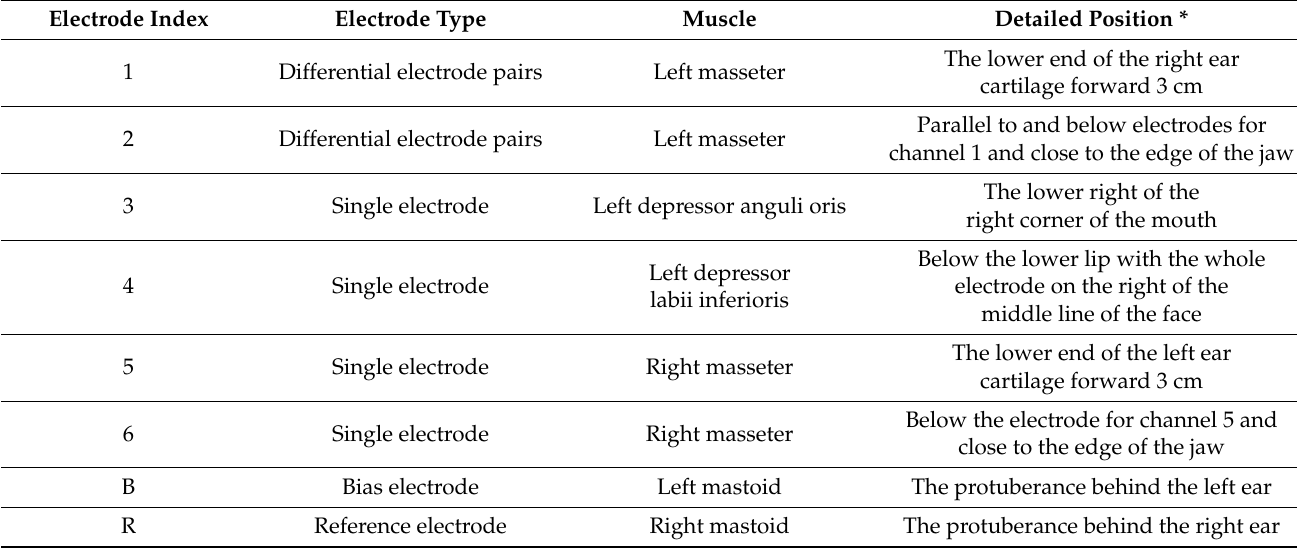
Figure 2. Electrodes position distribution. Circle with a number was the position of electrodes for 6 channels, and the number was the channel index. Electrodes for channels 1 and 2 were differential electrode pairs. Circle with the letters ‘B’ and ‘R’ were the positions of the bias electrode and reference electrode. Electrodes for channels 1, 2, 5, and 6 were arranged on masseters, the electrode for channel 3 was arranged on depressor anguli oris, and the electrode for channel 4 was arranged on depressor labii inferioris. In addition, the bias electrode and reference electrode were arranged on the left and right mastoid, respectively.